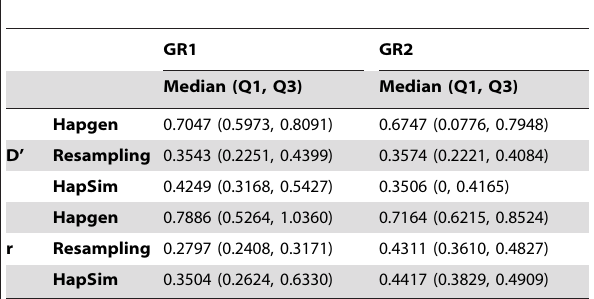
Table 3. Ratio of replicate SD to original SE for each SNP pair.